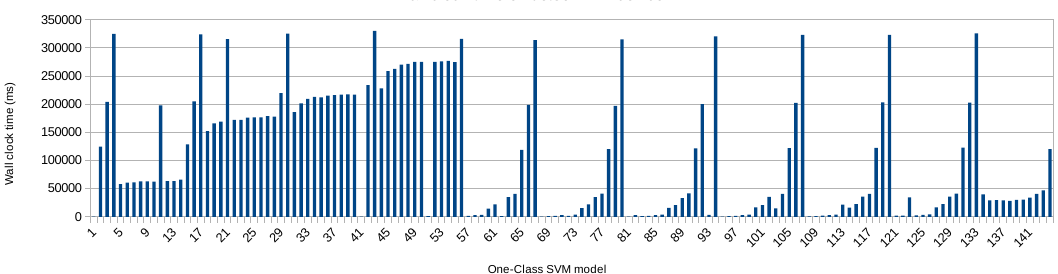
Figure 16. Wall clock time for all One-Class SVM models on the NVIDIA Jetson TX2